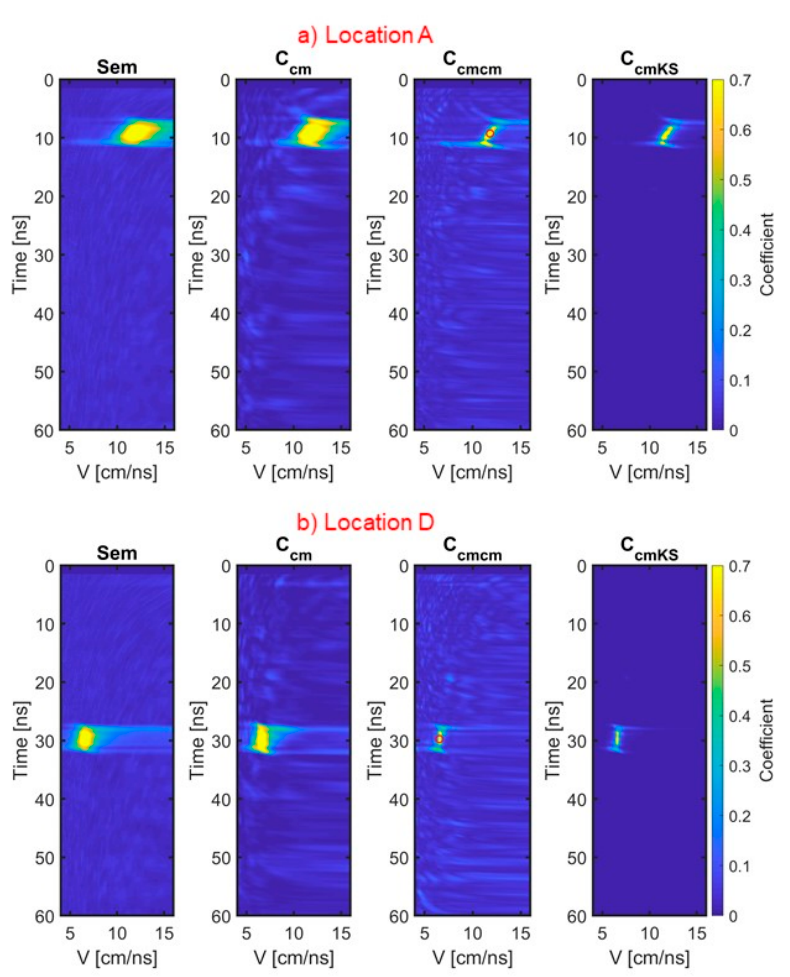
Figure 4. ( a ) Map of the coherency measure in location A; ( b ) map of the coherency measure in location D. These maps are obtained by the following functionals: Semblance ( Cs ), Complex Matched Analysis ( Ccm ), Complex Matched Coherency Measure ( Ccmcm ), and CcmKS , the combination of Ccm and Ccmcm . The higher velocity resolution of the functionals that make use of the data covariance matrix is clearly observed. The red circles correspond to the picked ( t 0 , Vs ) pairs that characterize the hyperbolic trajectories plotted in Figure 3. Colour scale and gain are identical for all functionals.